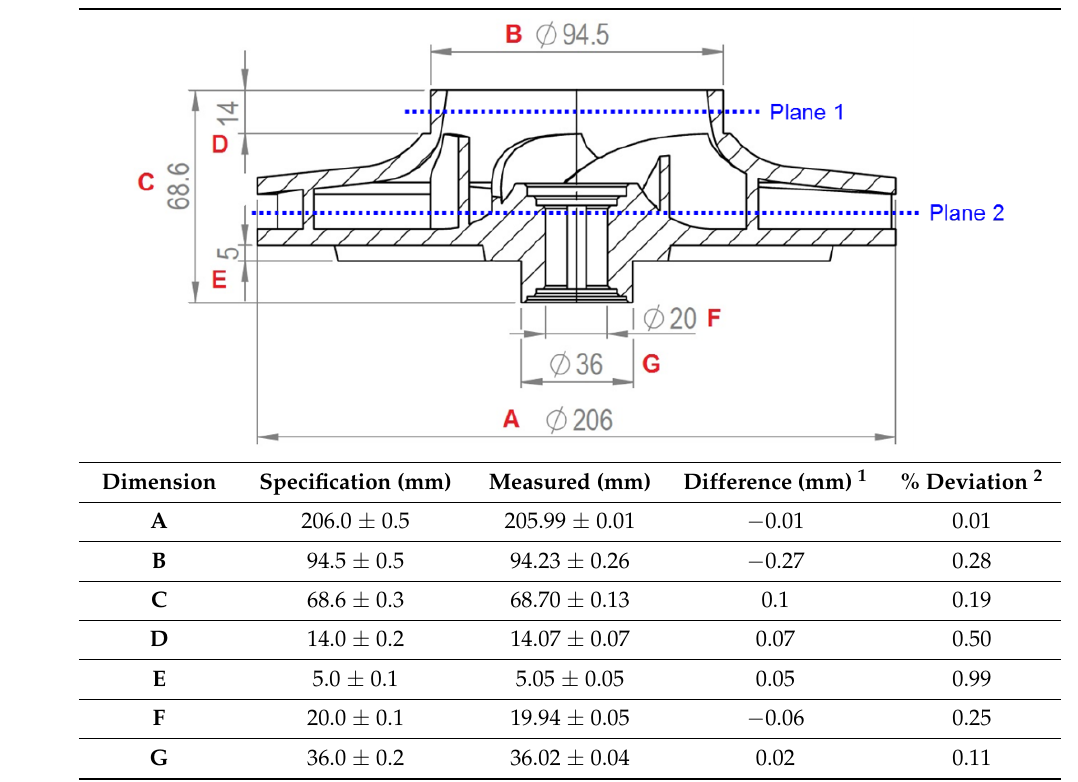
Table 4. Dimensional characterization of the BJ impeller.